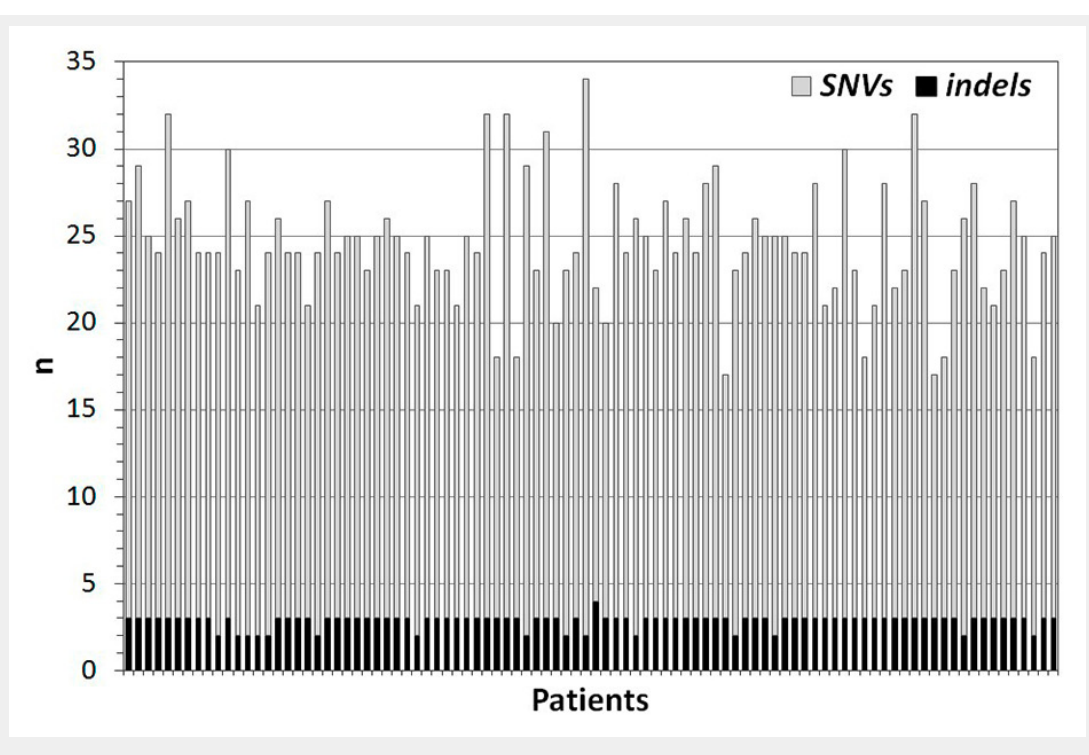
Figure 4 Number of SNVs and indels identified in each of the 94 patients for APOB , LDLR , and PCSK9 . Each bar corresponds to a single sample. SNV = single nucleotide variant; indel = short insertion and/or